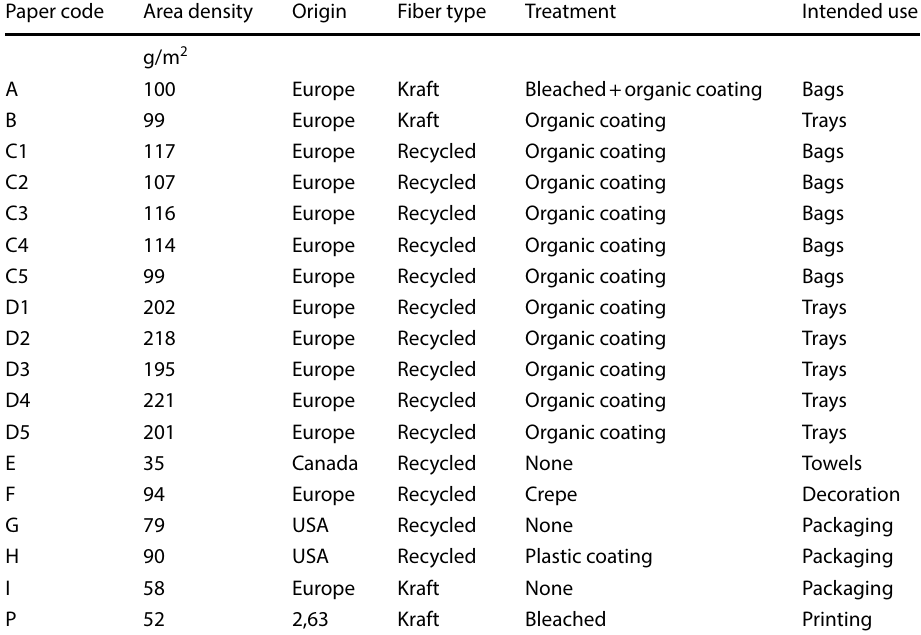
Table 1 Overview of paper types